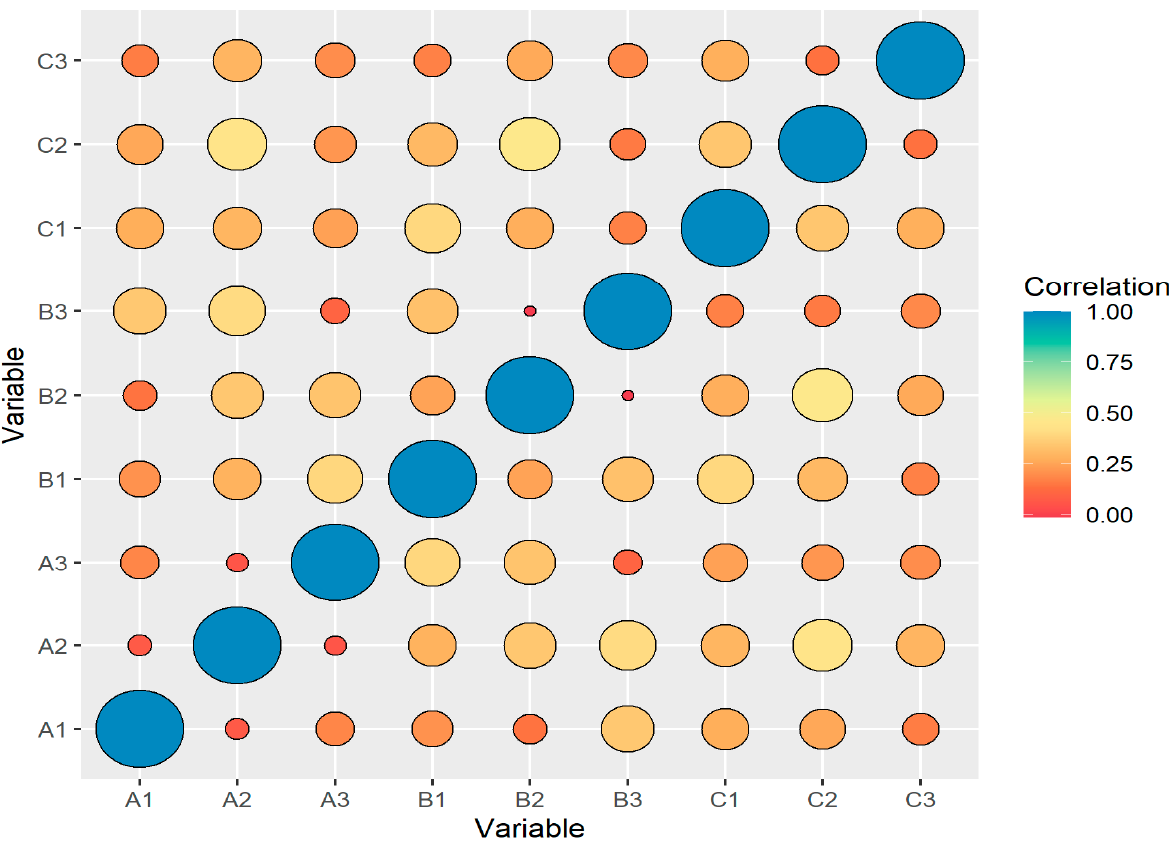
Figure 5. Spearman rank correlation between variables.